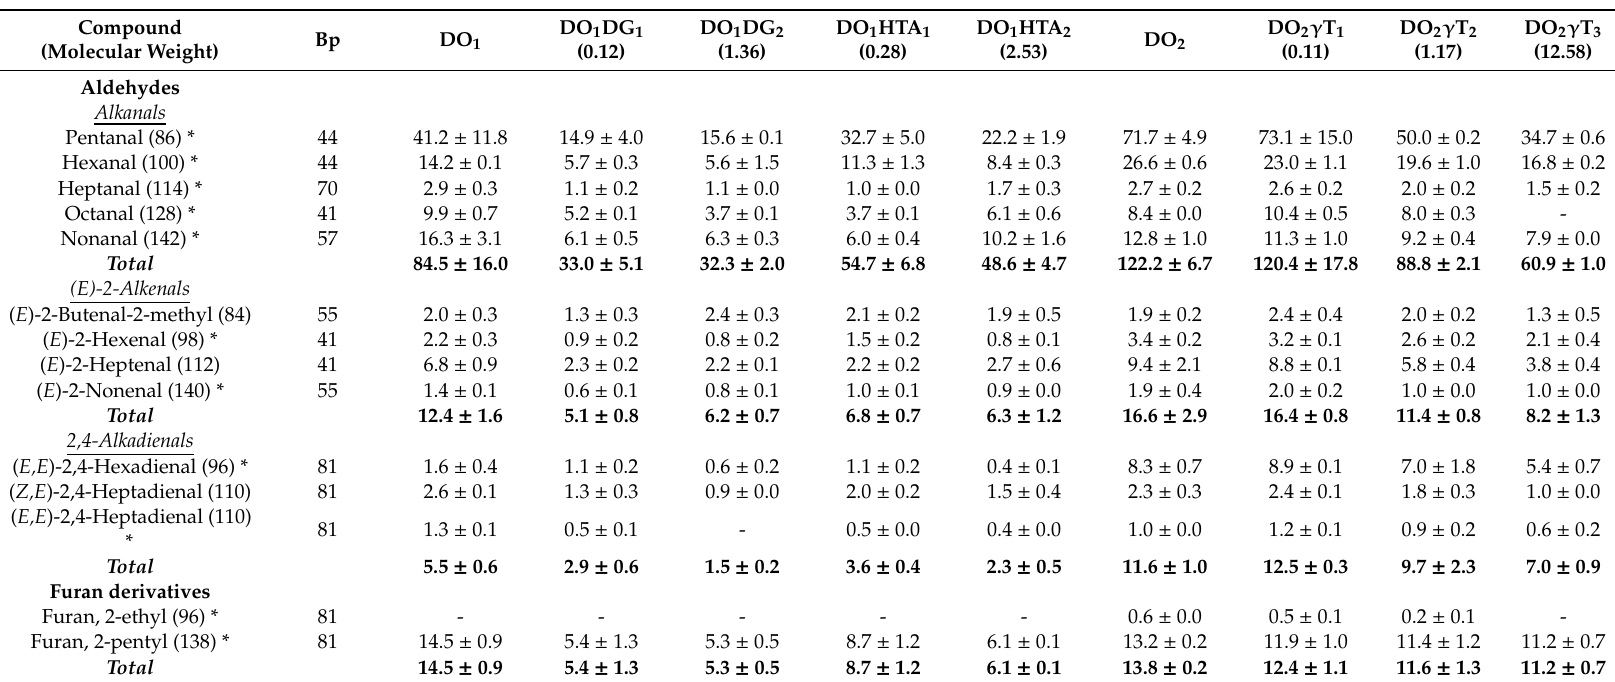
Table 5. Abundances of some oxidation markers extracted and identified by SPME-GC / MS in the headspace of digestates of non-enriched olive oils (DO 1 and DO 2 ) and in those of the samples enriched with dodecyl gallate, hydroxytyrosol acetate and gamma -tocopherol (DO 1 DG 1 , DO 1 DG 2 , DO 1 HTA 1 , DO 1 HTA 2 , DO 2 γ T 1 , DO 2 γ T 2 and DO 2 γ T 3 ) whose level of enrichment in phenolic compounds is given in brackets in mmol / mol (AG + FA) O . Data are expressed as area counts of the mass spectra base peak (Bp) of each compound multiplied by 10 -6 , and obtained as average of two determinations together with their standard